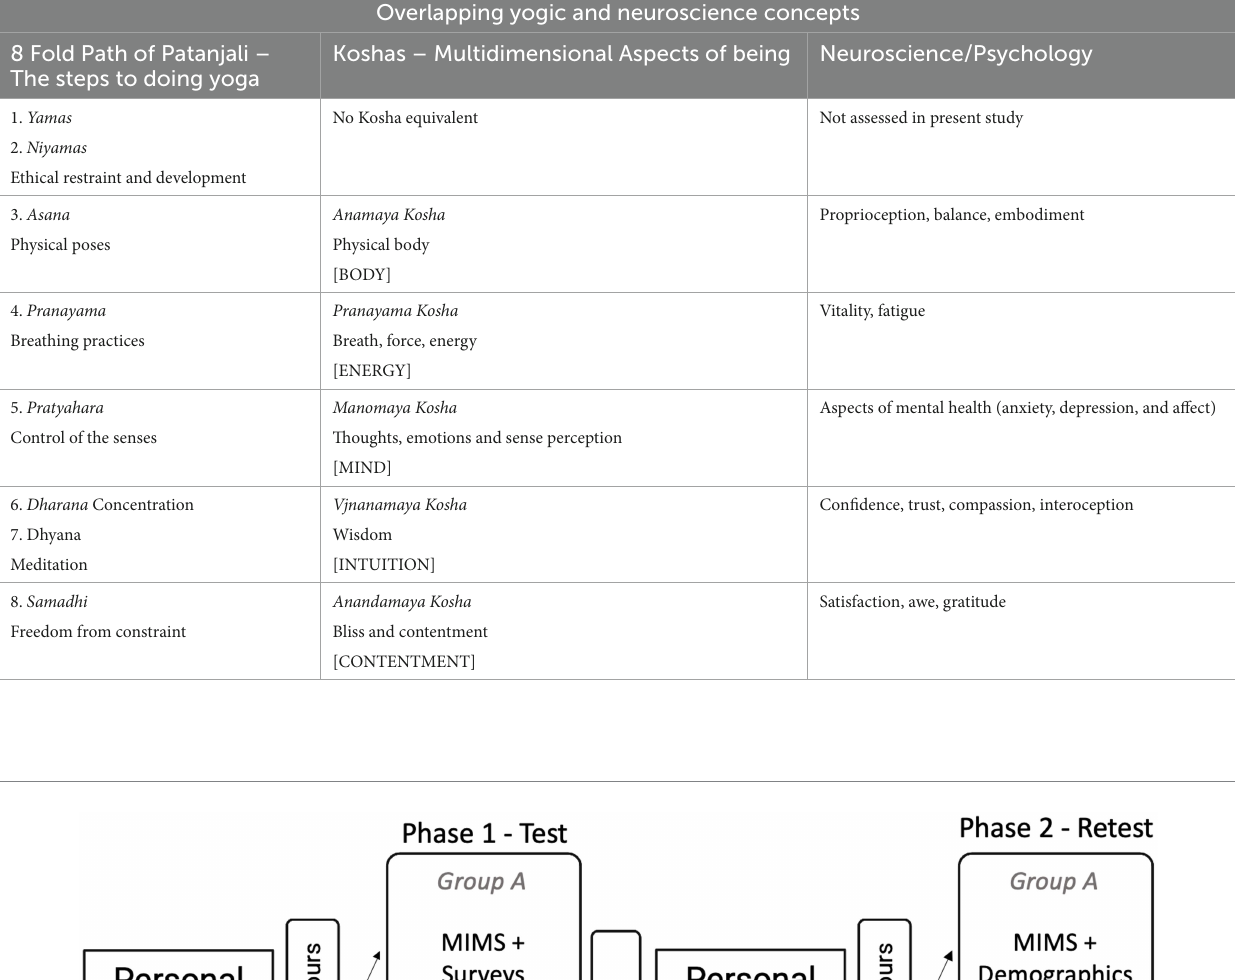
TABLE 1 Overlapping yogic and neuroscientific concepts regarding the multidimensional aspects of being. Overlapping yogic and neuroscience concepts